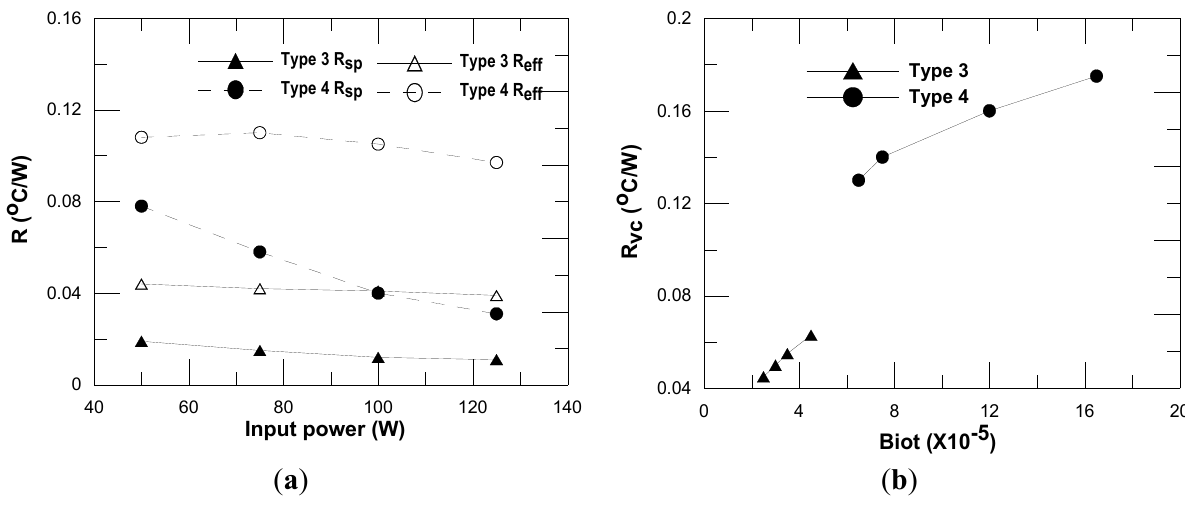
Figure 4. ( a ) Effects of the supporting structure of the heat pipe on R